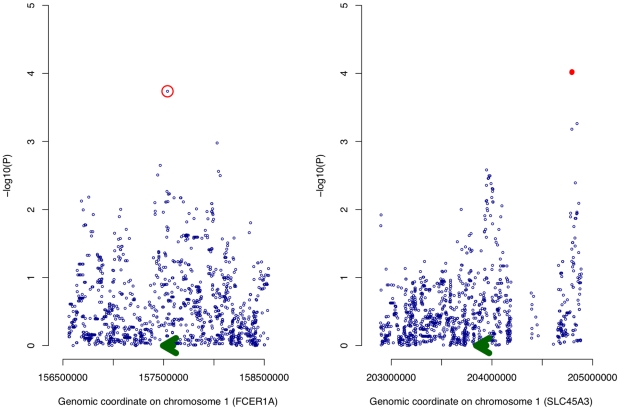
Association of genetic variation with expression of FCER1A and SLC45A3.For each cis SNP proximal to FCER1A and SLC45A3, a simple linear model is fitted and the regression P value (−log10 transformed) plotted along the vertical axis with genomic position of the SNP along the horizontal axis (both on chromosome 1). The two adjacent SNPs passing a permutation threshold of 0.05 are denoted by red dots while the SNP (rs2251746) within FCER1A found to drive expression of the LL module is circled in red. The position of the expression probe and the direction of transcription are denoted by a green arrow.